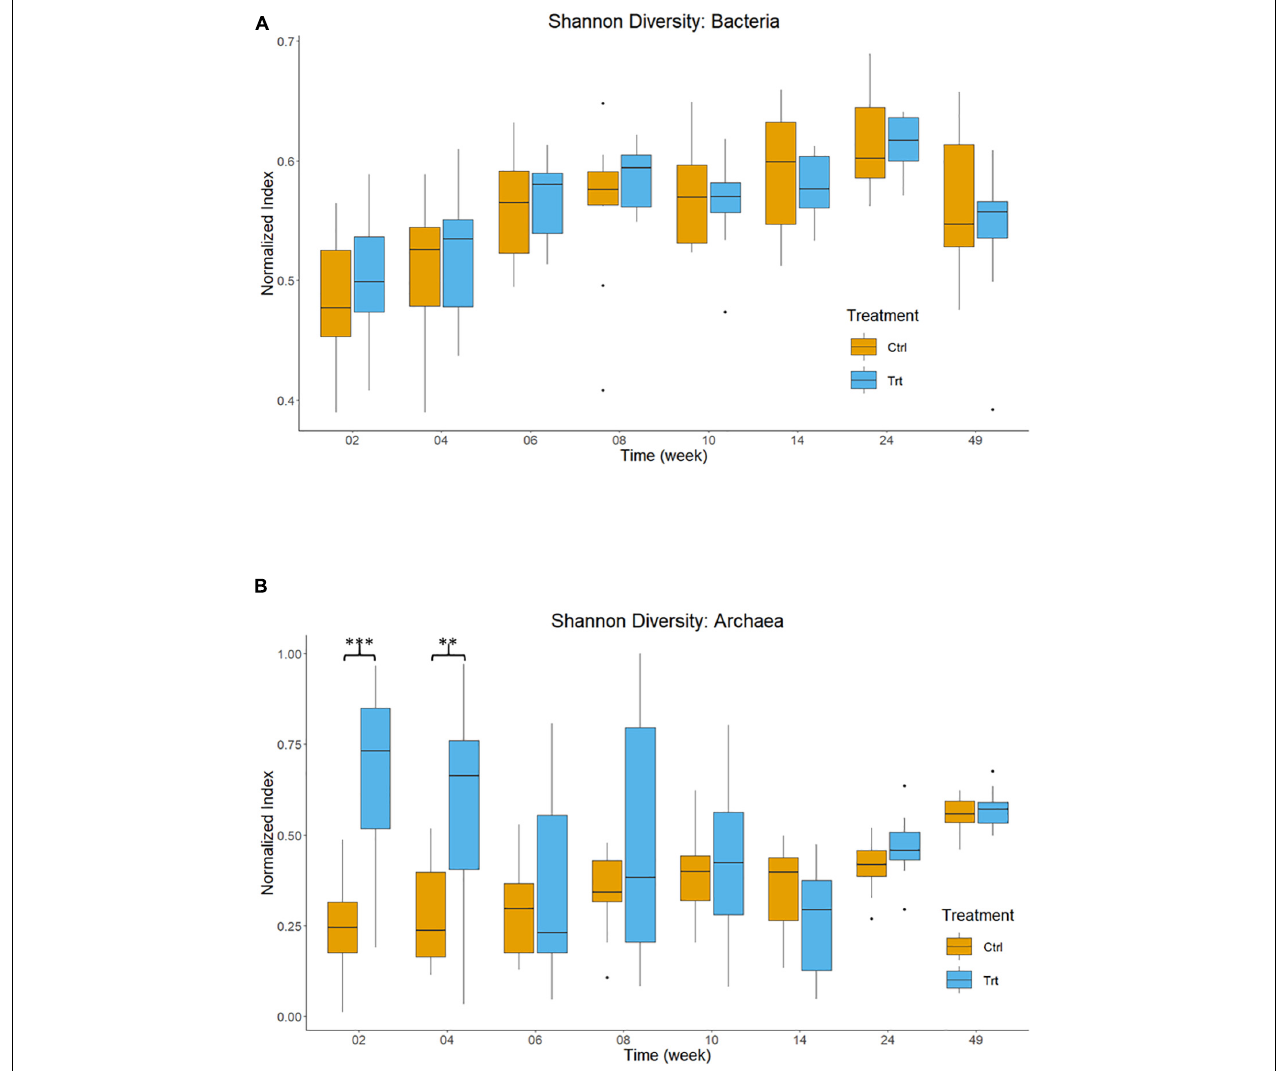
FIGURE 2 | Shannon diversity indices of the rumen microbiota in control (orange) and treatment (blue) calves across different ages. Calves during the rearing time were fed as follows: milk twice a day and ad libitum control and treatment concentrates at weeks 2 and 4; milk once a day and ad libitum control and treatment concentrates and partial mixed diet (PMR) diet at weeks 6, 8, and 10; concentrates step-down weaned and PMR diets fed ad libitum until week 14; and grazing a mixed sward of ryegrass/clover as one mob at weeks 24 and 49. Sampling times were from 2 to 49 weeks. Shannon index for (A) bacteria and (B) archaea. Boxplots represent the 25th and 75th percentiles, lines within boxes are the medians, the whiskers extend to the most extreme data points, and dots represent the outliers. Significance of pairwise comparisons (Tukey post hoc analysis) between treatments are indicated by asterisks as: ** P < 0.010; *** P <